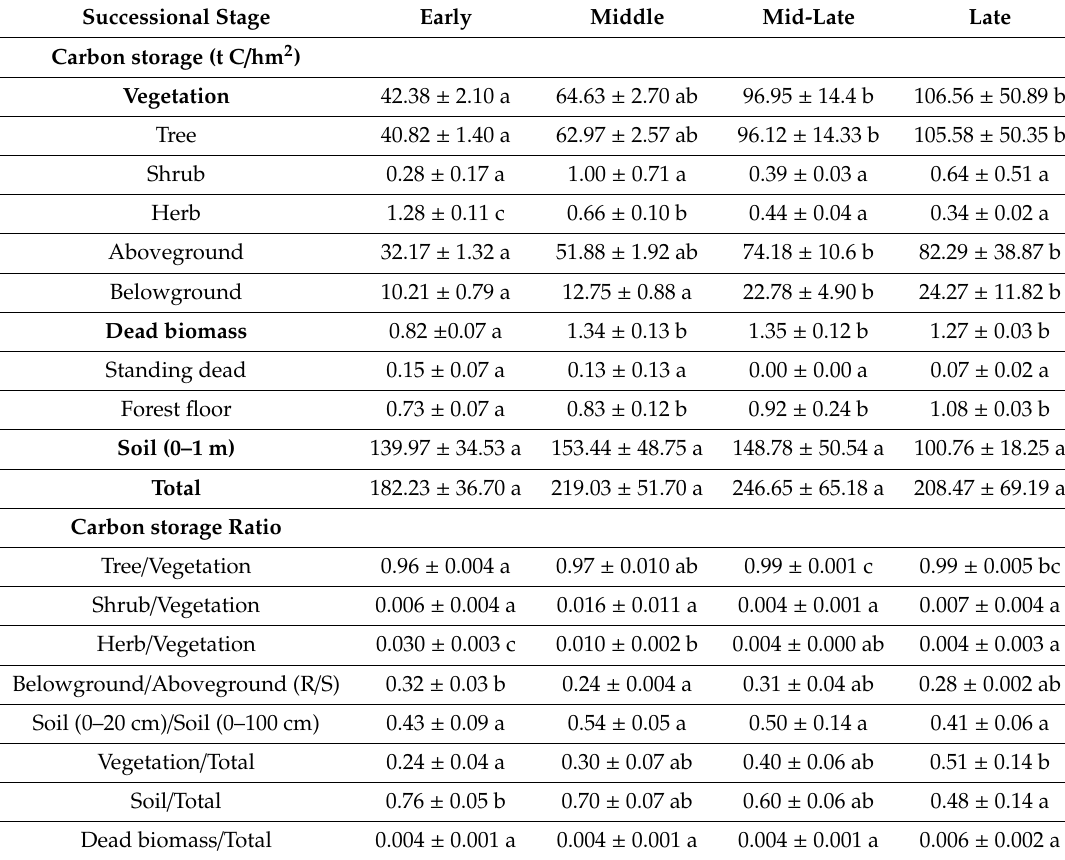
Table 2. Carbon storage (t C / hm 2 ) and allocation pattern in di ff erent successional stages of BKFs ecosystem (mean ± within